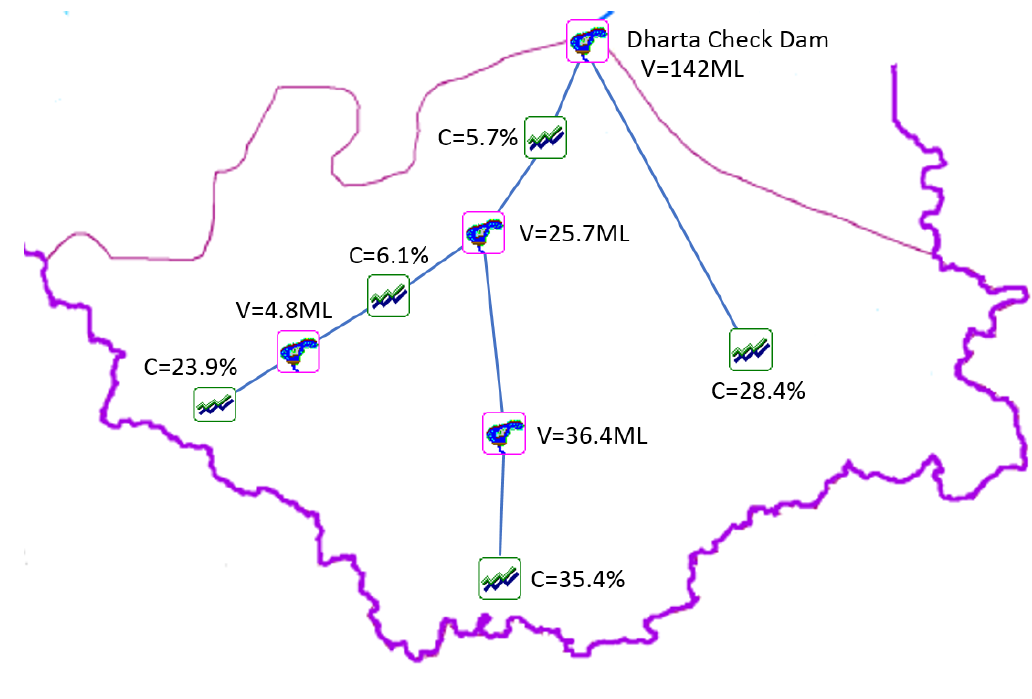
Table 4. Capacities of existing check dams in all